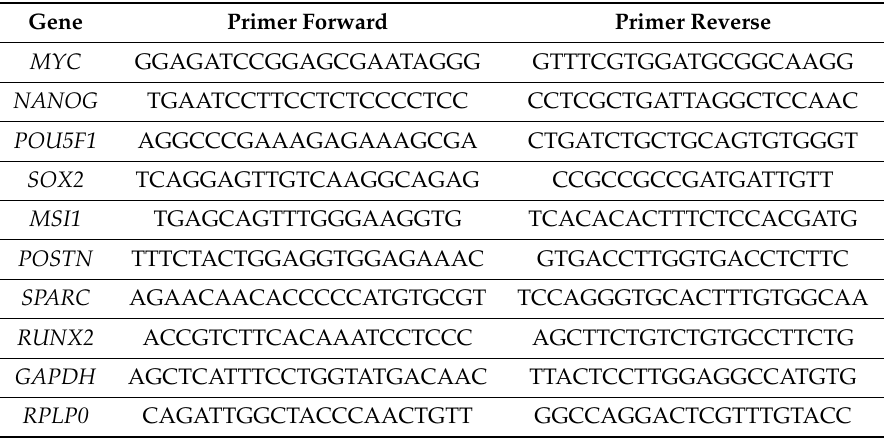
Table 5. Sequence of each of the primers for the genes evaluated in the current study.